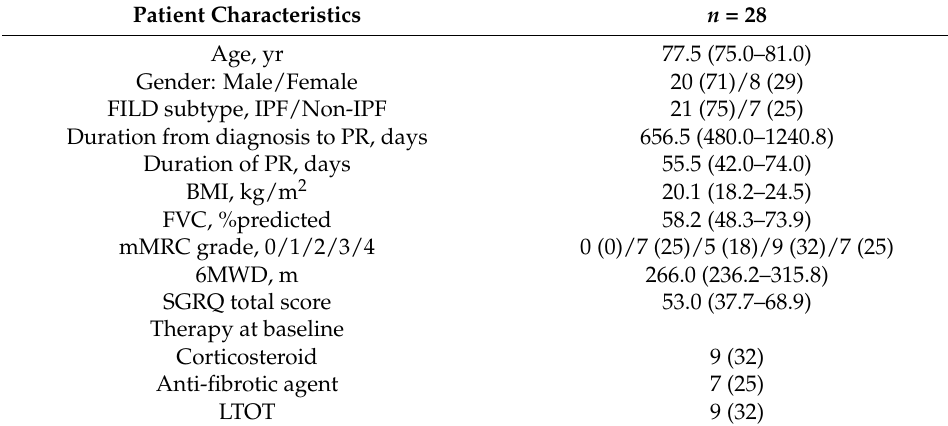
Table 1. All patient baseline